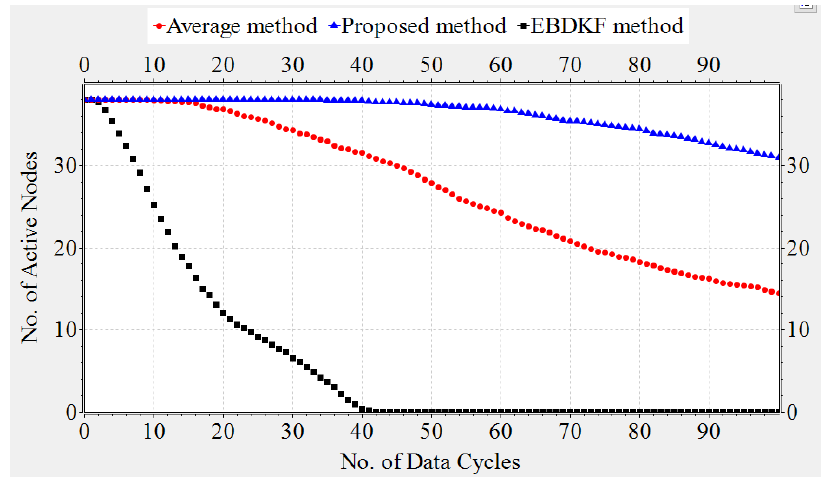
Figure 18. Network lifetime comparison for 3 information fusion methods in a tree-based IoT platform having 38